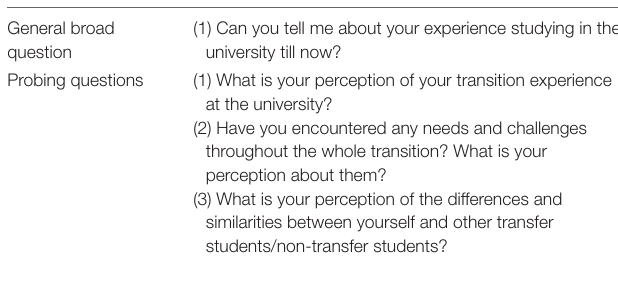
TABLE 2 | Interview guide to explore the transition experiences of transfer students. General broad